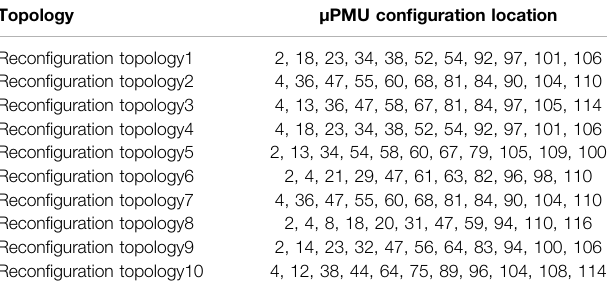
TABLE 2 | μ PMU con fi guration scheme.